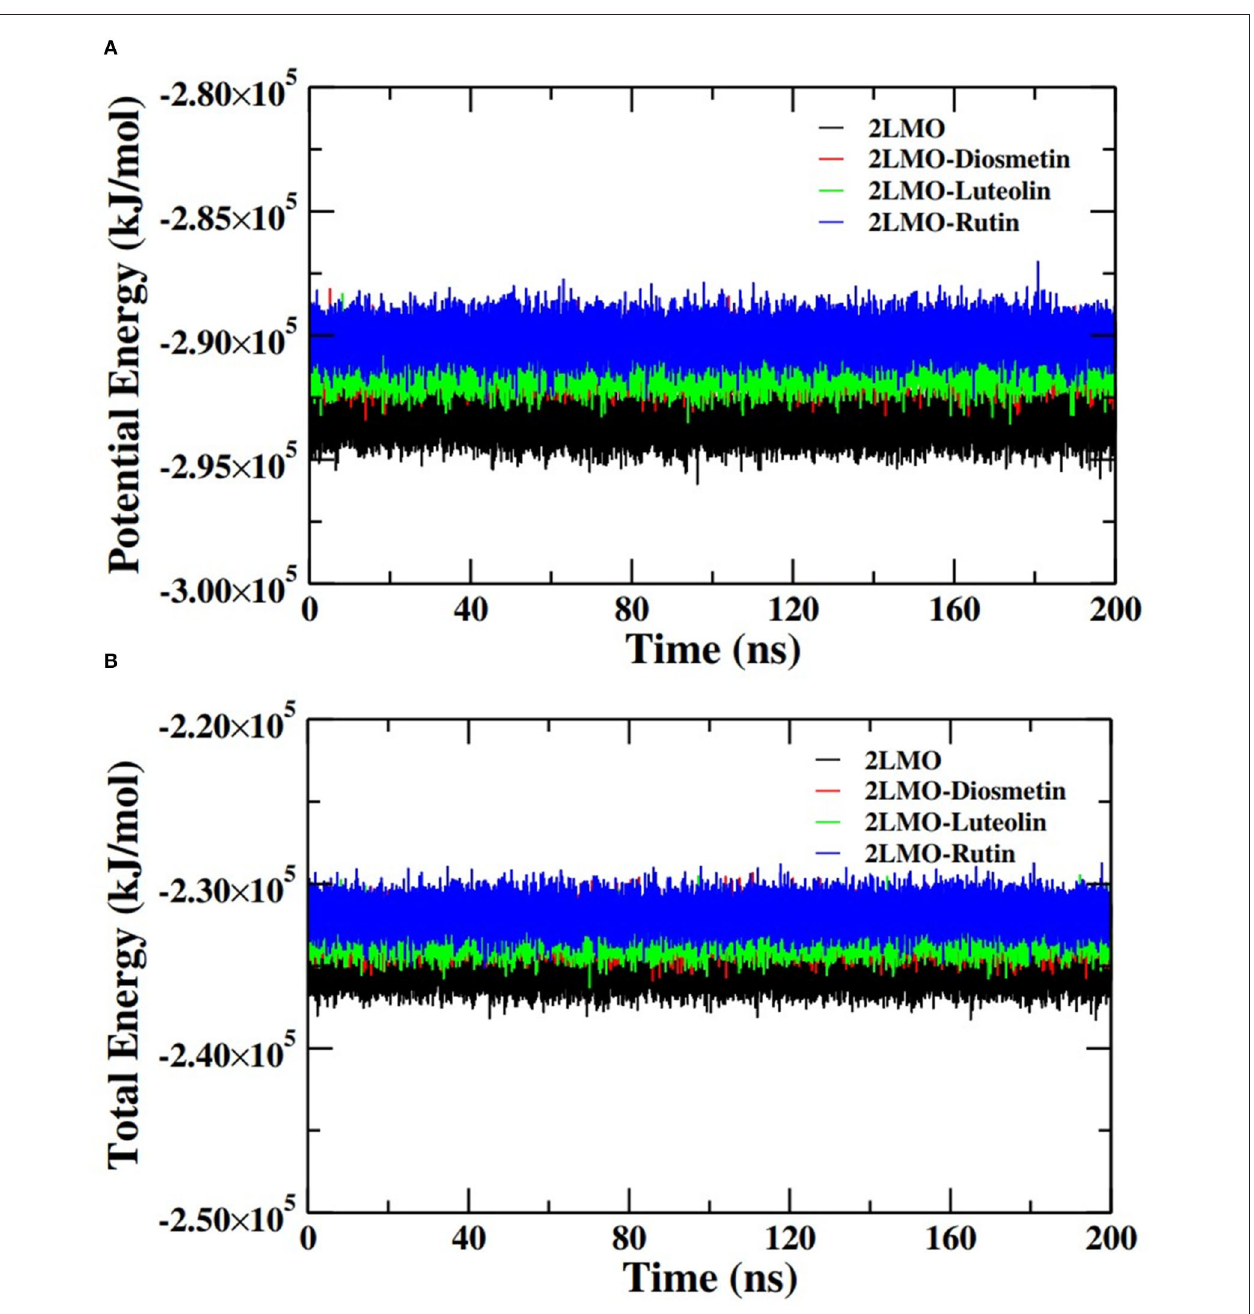
FIGURE 6 | (A) Potential energy (PE) and (B) total energy (TE) of the systems of 2LMO and its complexes with Diosmetin, Luteolin and Rutin as a function of time.